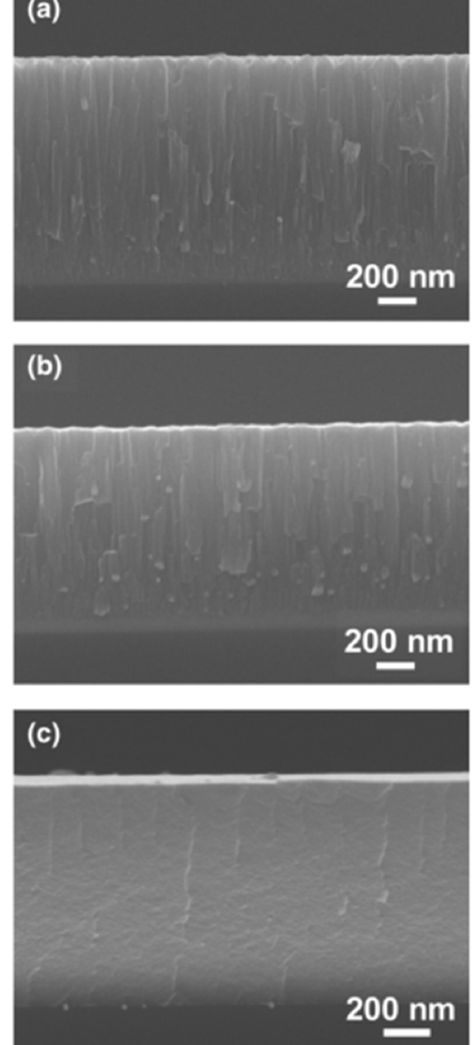
Figure 4. Cross-sectional SEM micrographs of (Al 1.5 CrNb 0.5 Si 0.5 Ti)N x coatings deposited at substrate bias of ( a ) 0 V; ( b ) −50 V and ( c ) −150 V.. Reprinted with permission from [53]. 2012, Elsevier.